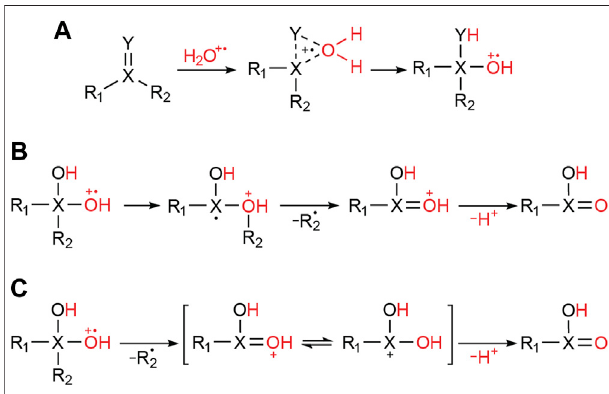
FIGURE 2 | Possible processes for water radical cation adduct formation with a double bond-containingcompound. (A) Direct attachmentof the water radical cation (monomer or dimer) to the reactant. (B) Oxidation of the substrate by 1,2-migration and sigma bond cleavage. (C) Oxidation of the substrate by geminal diol cation formation after direct sigma bond